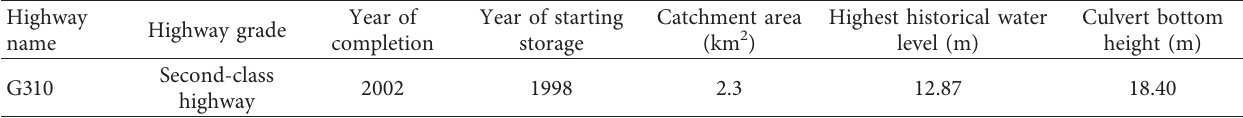
Table 1: Data of DE at G310 highway.